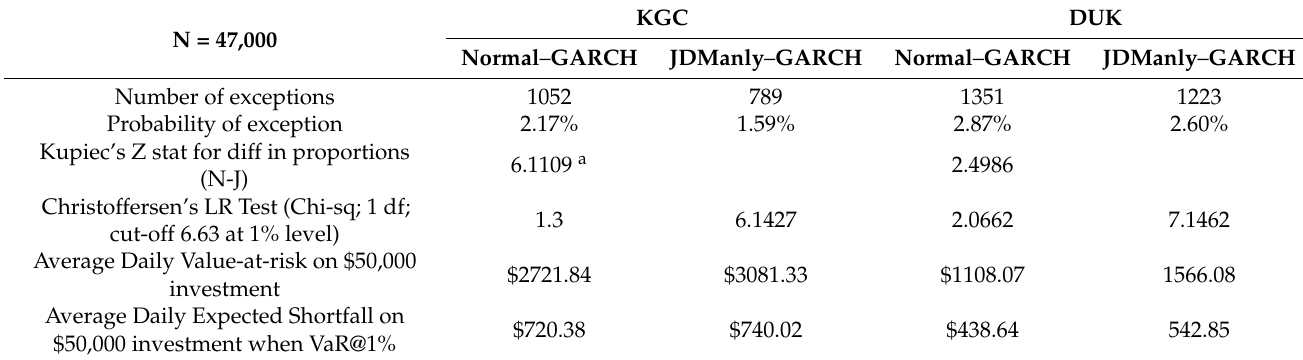
Table 4. Results of backtesting value-at-risk and expected Shortfall estimates with GARCH (1, 1) volatility updation. Panel A. Results for the KGC and DUK stocks from the US market, based on 100 day rolling estimation window, and 125